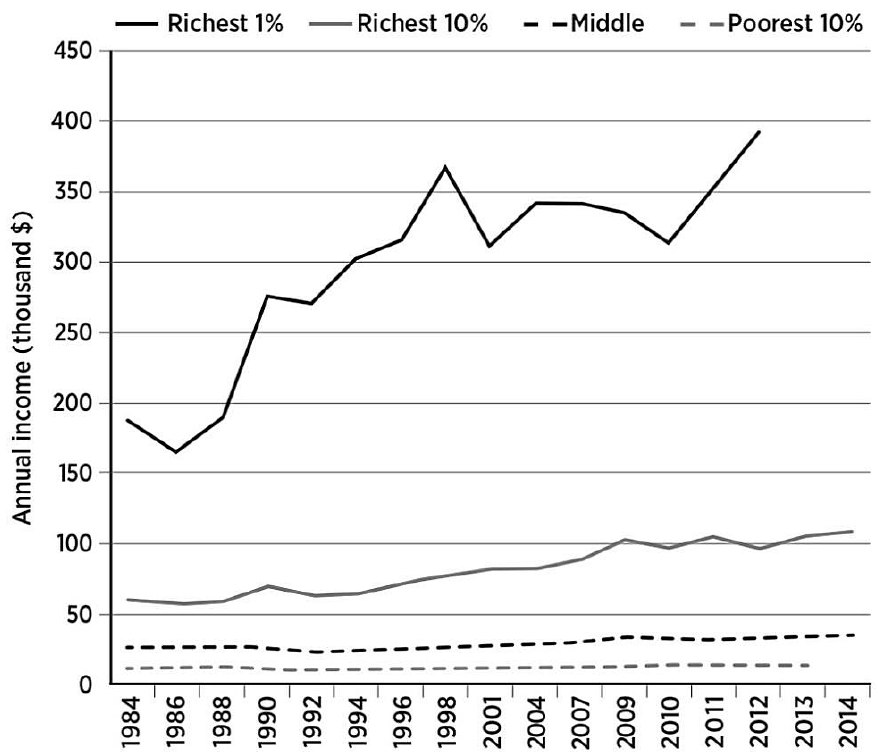
Figure 2. Annual average disposable incomes for 4 groups in New Zealand shown in 2012 NZD equivalents and adjusted for inflation rates. Steep rises for the richest 1% contrast with very small increases for the poorest 10%. Reproduced with permission from [23]. Copyright Bridget William Books, Wellington, New Zealand, 2015.